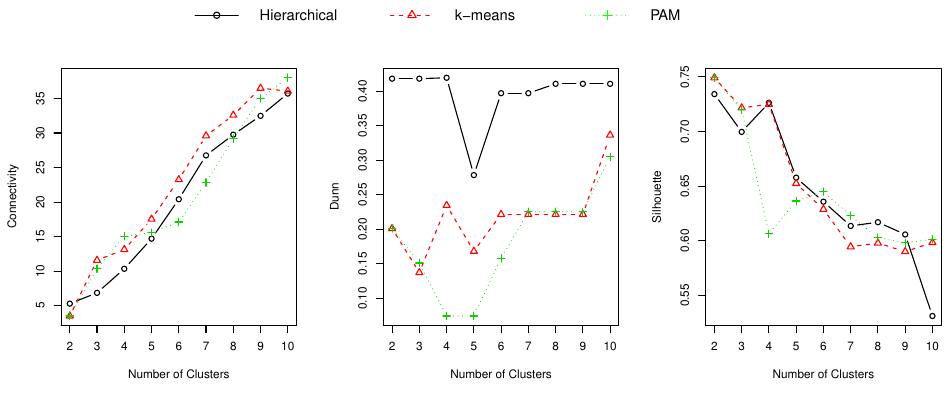
Figure 6. Internal cluster validation for customer segmentation based on the characteristic typical load